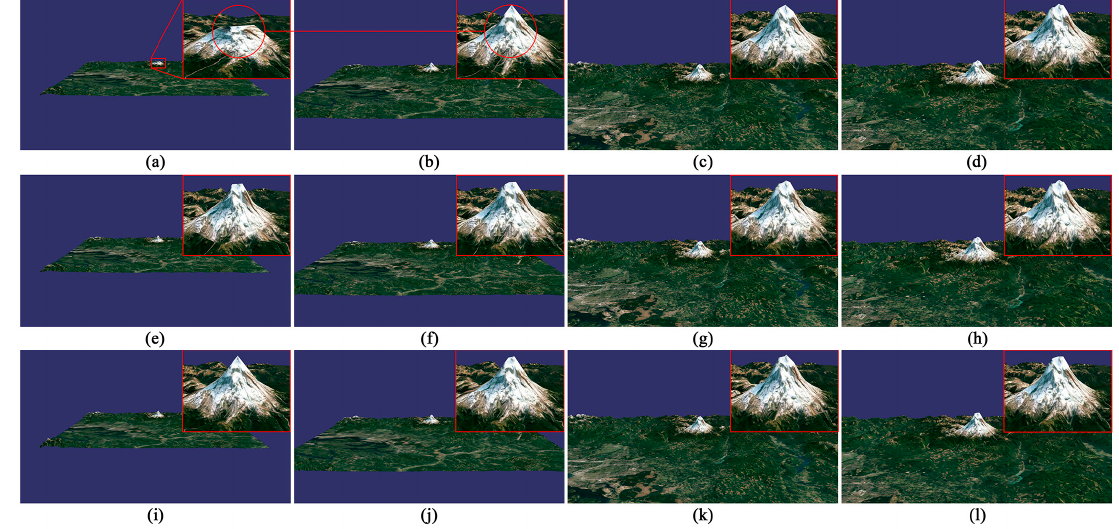
Figure 15. Visual effect comparison in Area I: ( a – d ) Method I. ( e – h ) Method II. ( i – l ) Our method.